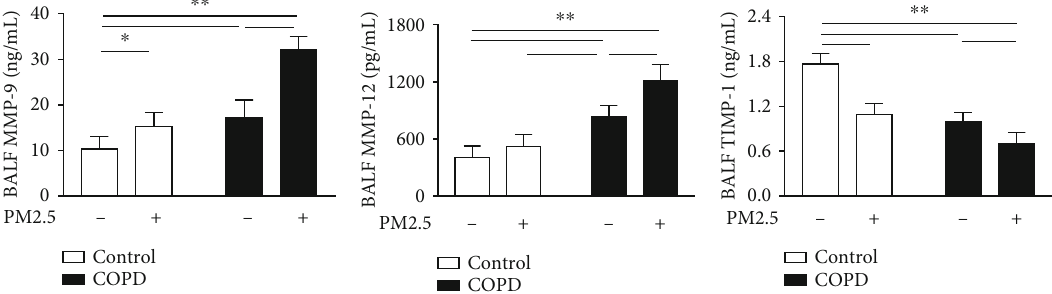
Figure 8: The e ff ect of PM2.5 on protease-antiprotease imbalance in rats with COPD. Level of MMP-9, MMP-12, and TIMP-1 in the BALF of rats in each group. MMP-9: matrix mettaloproteinase-9; TIMP-1: tissue inhibitors of metalloproteases-1. The data are expressed as the means ± SD ( n = 7 ). ∗∗ p < 0 : 01 , ∗ p < 0 : 05